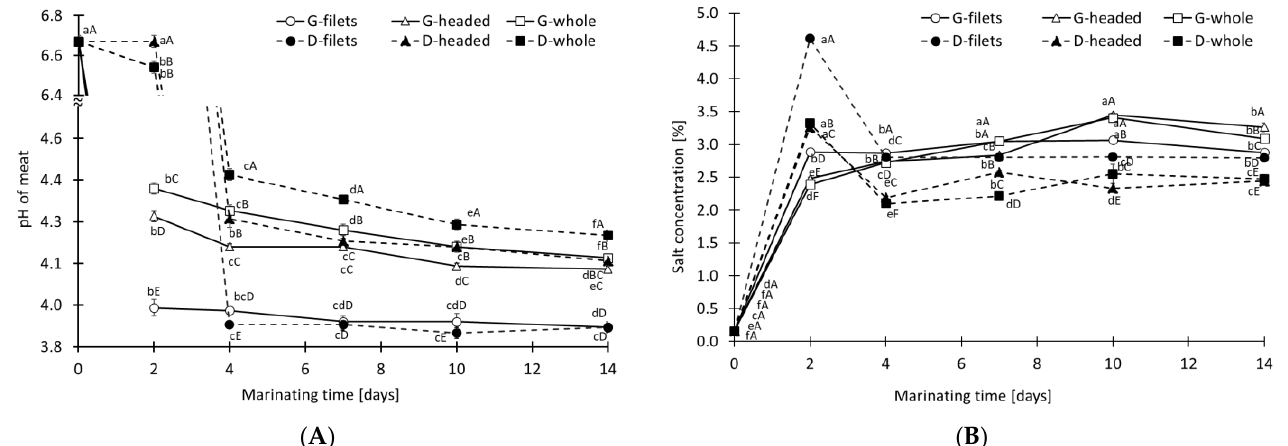
Figure 4. Effect of marinating method (G- — German, D- — Denmark) and degree of primary processing of Baltic herring (whole, headed, fillets) on ( A ) mass yield and ( B ) moisture during marinating. a,b,c Results marked with the same lower case letter do not statistically differ by the influence of marinating time; A,B,C Results marked with the same capital letter do not statistically differ by the influence of the marinating method. For a better presentation of the results, a break ( ≈ ) in the Y axis was used.